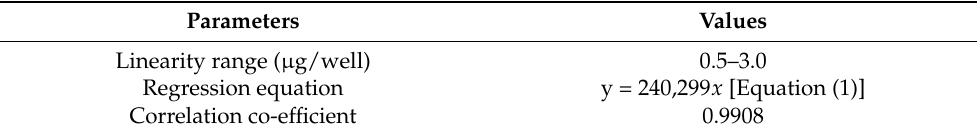
Table 1. Linear regression data for the calibration curve of MrNV CP ( n = 6).